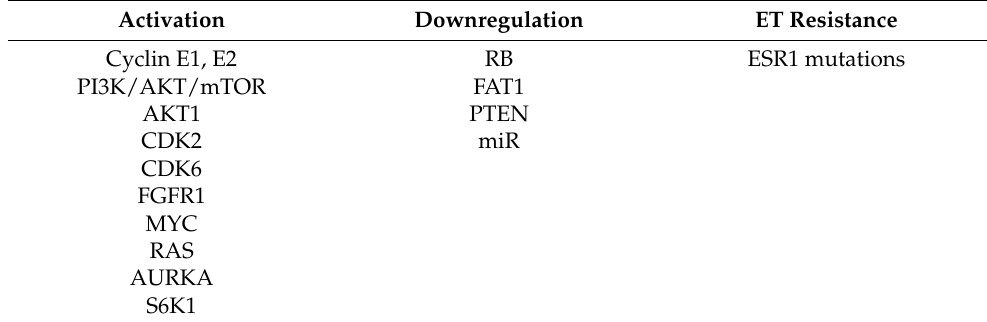
Table 2. The main resistance mechanisms and biomarkers of resistance to CDK 4/6 inhibitors.